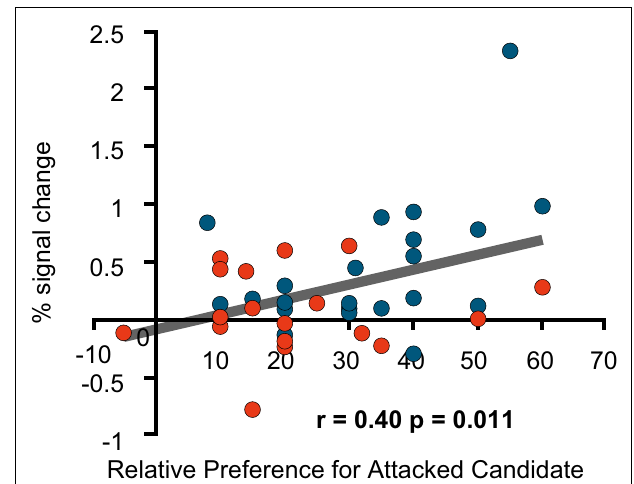
FIGURE 7 | fMRI signal change at the medial prefrontal cortex. The fi gure shows the correlation between the signal change at ( − 16, 39, 44; BA8) during the negative advertisements and the relative preference for a favoured candidate before the negative advertisements (=the pre-session rating of the attacked candidate − the pre-session rating of an attacking candidate).